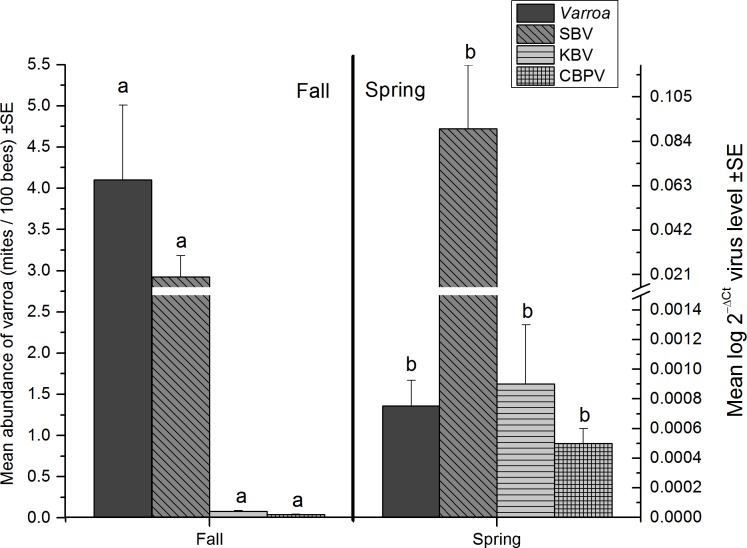
Effect of season (fall and spring) on mean abundance of Varroa (left axis) and concentrations of viruses (SBV, KBV and CBPV) (right axis) (± standard error) (see Table B in S1 File). Data represent pooled levels for both wintering methods (indoor and outdoor) and both sampling locations (brood area and entrance). Means followed by the same letter within a parasite or pathogen group are not significantly different (P > 0.05, Slice).